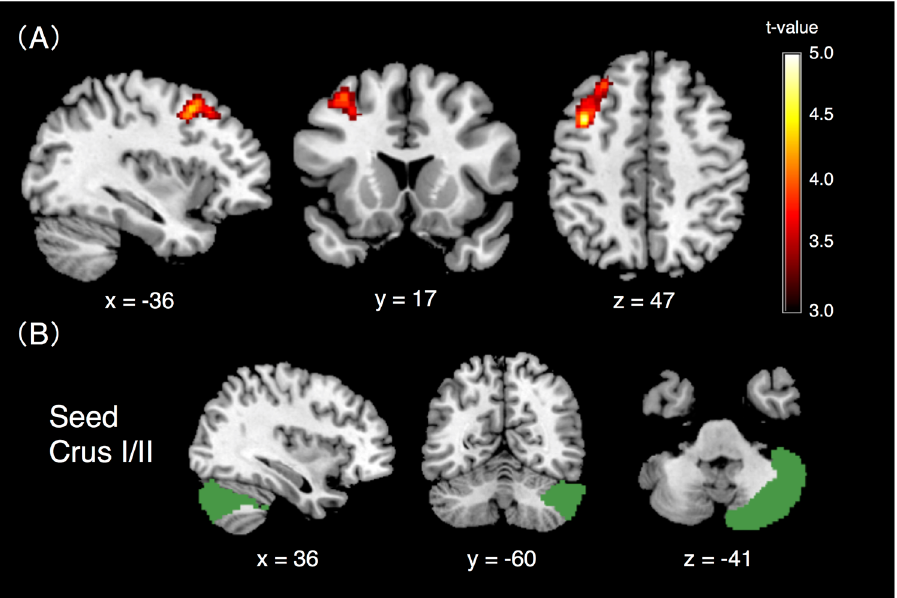
Figure 1. ( A ) Significant difference in functional connectivity of Crus I/II between ADHD and TD groups by seed-based analysis. Children with ADHD showed significantly lower functional connectivity of the right Crus I/II with the left DLPFC (MNI coordinates, x = − 38, y = 10, z = 48; cluster size = 311 voxels; p = 0.011, FWE corrected at cluster level). ( B ) Crus I/II, which was used as seed (Figure shows only right Crus I/II). TD, typically developing; DLPFC, dorsolateral prefrontal cortex; MNI, Montreal Neurological Institute; FWE, family wise